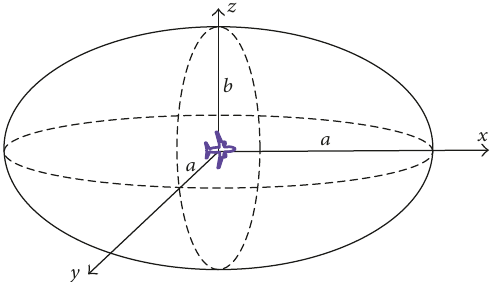
Figure 1: Illustration of the ellipsoid-shaped protection zone